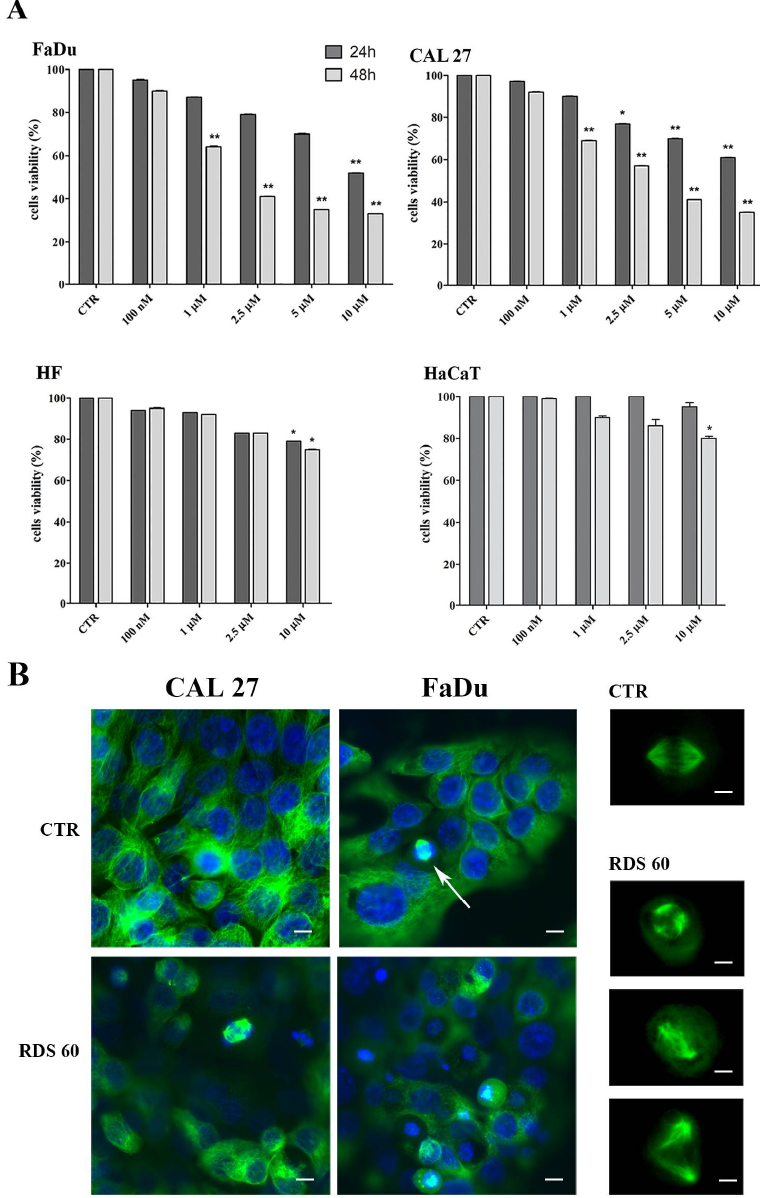
Figure 2. Effects of RDS 60 on proliferation and mitotic spindle formation. ( A ) Cell viability of untreated (CTR) and RDS 60 treated FaDu, CAL27, HF and HaCaT expressed as percentages of alive cells ± SD. Treatments were performed for 24 and 48 h. * p < 0.01; ** p < 0.001. ( B ) Immunofluorescence staining of beta tubulin on CAL27 and FaDu untreated (CTR) and 1 μM RDS 60 treated for 24 h; bar 5 μm. The arrow shows a normal mitotic spindle. Smaller panels show mitotic spindles at higher magnification from untreated (CTR) and RDS 60 treated cells; bar 2 μm.